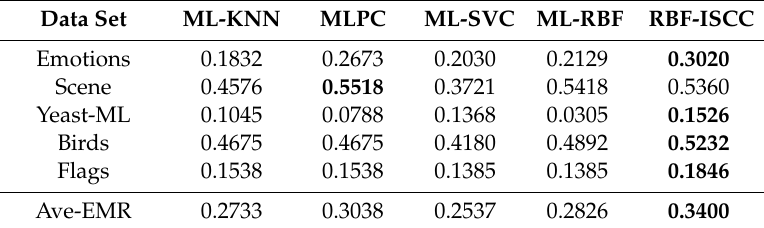
Table 8. Testing exact match ratio (EMR) obtained for multi-label data sets.